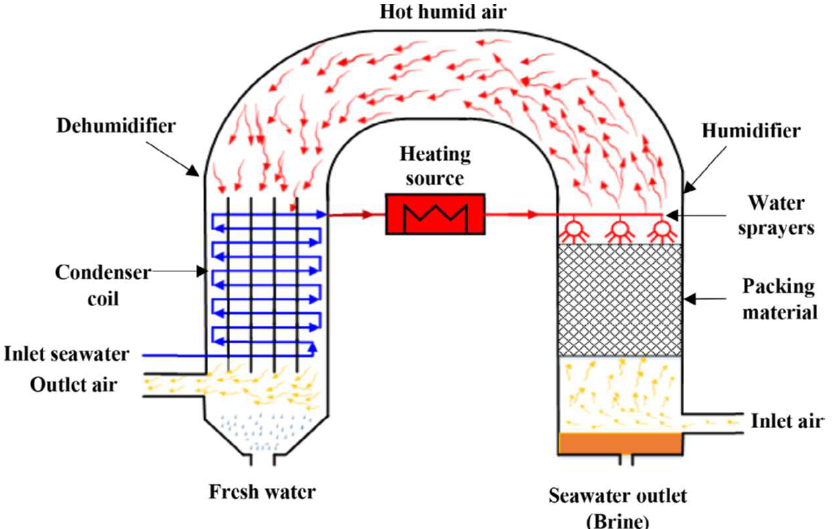
Figure 4. Desalination of HD in a straightforward manner. Reproduced with permission from A.